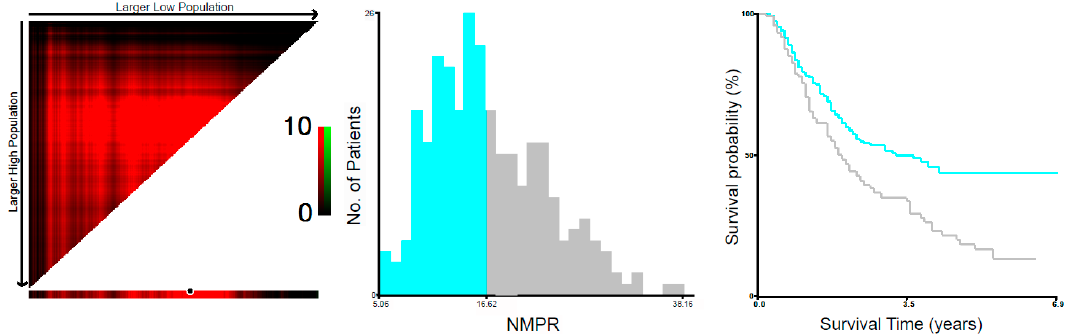
Figure 1. Determination of cut-off values of NMPR level in the training cohort and overall survival analyses. NMPR, neutrophil–mean-platelet-volume–platelet ratio.